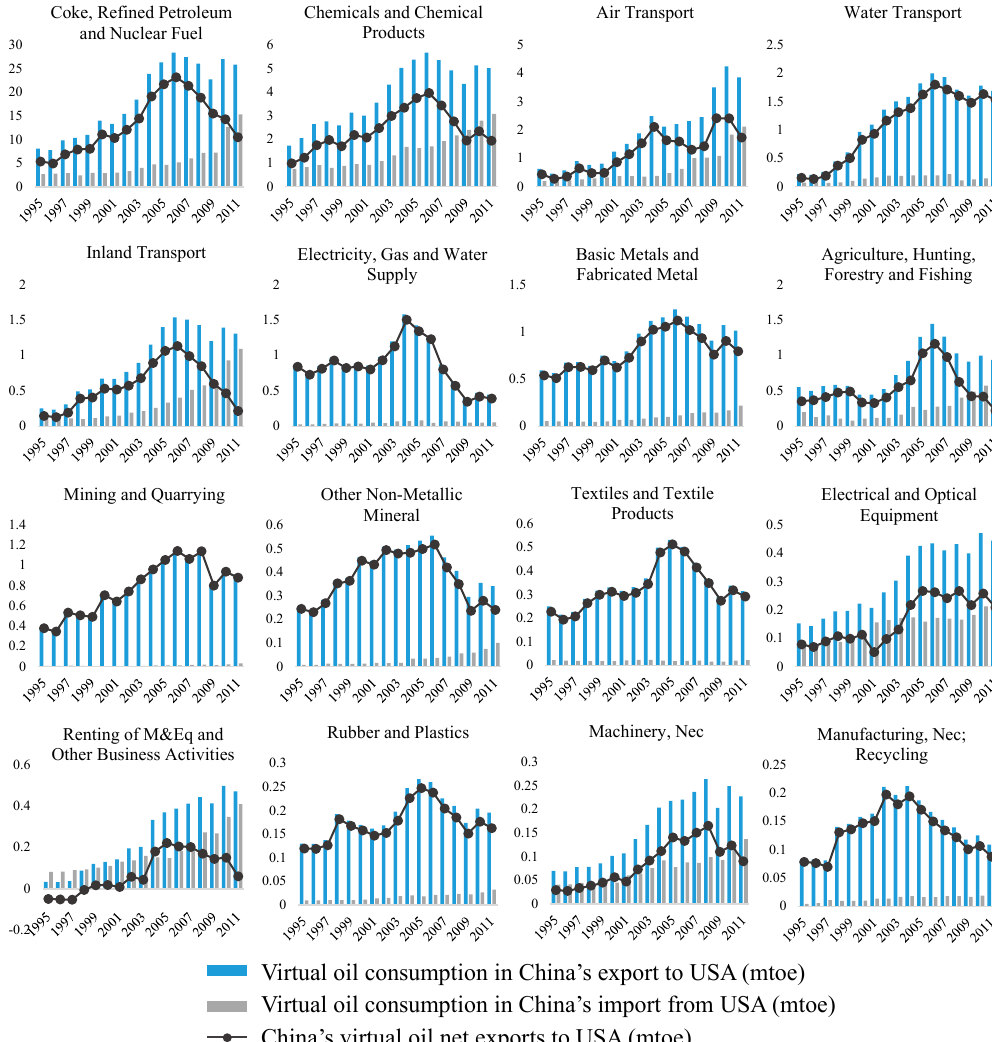
Figure 6. The changes in virtual oil flow in typical sectors.